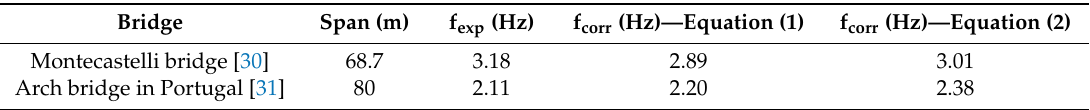
Table 2. Predictive performance of the empirical correlations for the estimation of the fundamental frequencies of RC arch bridges. Bridge Span